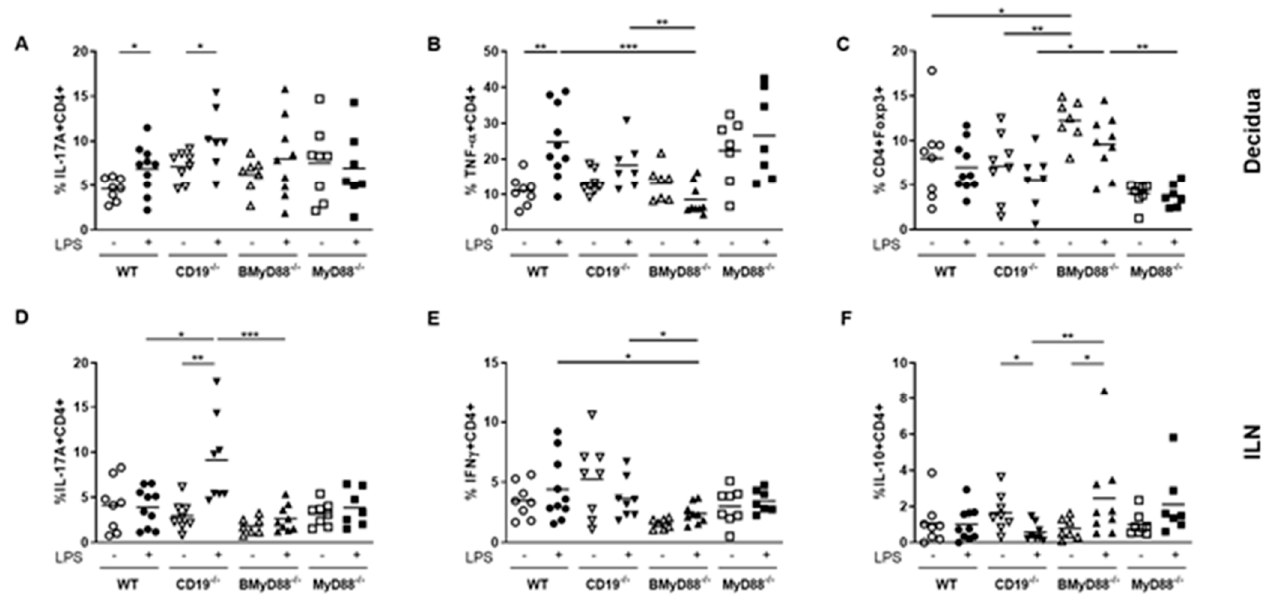
Figure 4. Loss of MyD88 or CD19 in B cells influences proinflammatory and regulatory T-cell population frequencies. Analysis of T cell populations in the decidua and inguinal lymph nodes (ILNs) of WT, BMyD88 -/- , CD19 -/- and MyD88 -/- mice was performed at gestational day (gd) 11, 24 h after LPS or PBS injection. The frequencies of IL-17A + CD4 + T cells ( A ), TNF- α + CD4 + T cells ( B ) and CD4 + Foxp3 + Tregs ( C ) in the decidua, and IL-17A + CD4 + T cells ( D ), IFN- γ + CD4 + T cells ( E ) and IL-10 + CD4 + T cells ( F ) in the ILNs were analyzed by flow cytometry. The Kruskal–Wallis test and Mann–Whitney U test were used to analyze the data. N = 7–9 mice/group; * p < 0.05, ** p < 0.01, *** p < 0.001. Shown are the mean values.